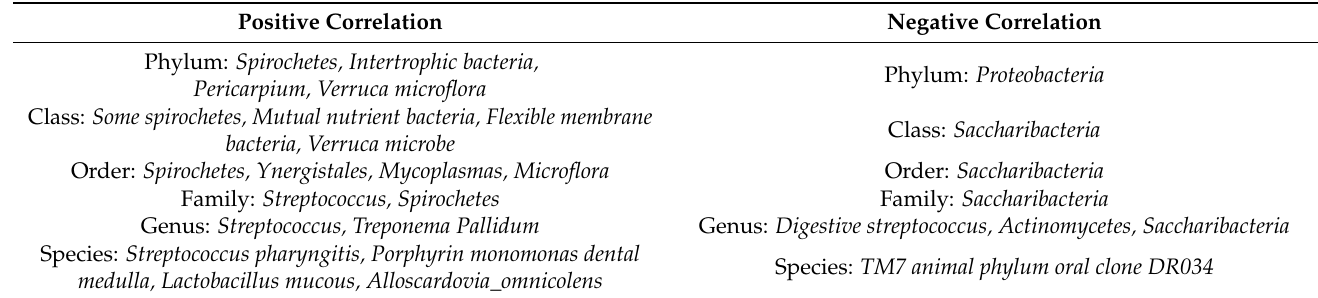
Table 2. Correlation between TG-4 and oral saliva bacterial